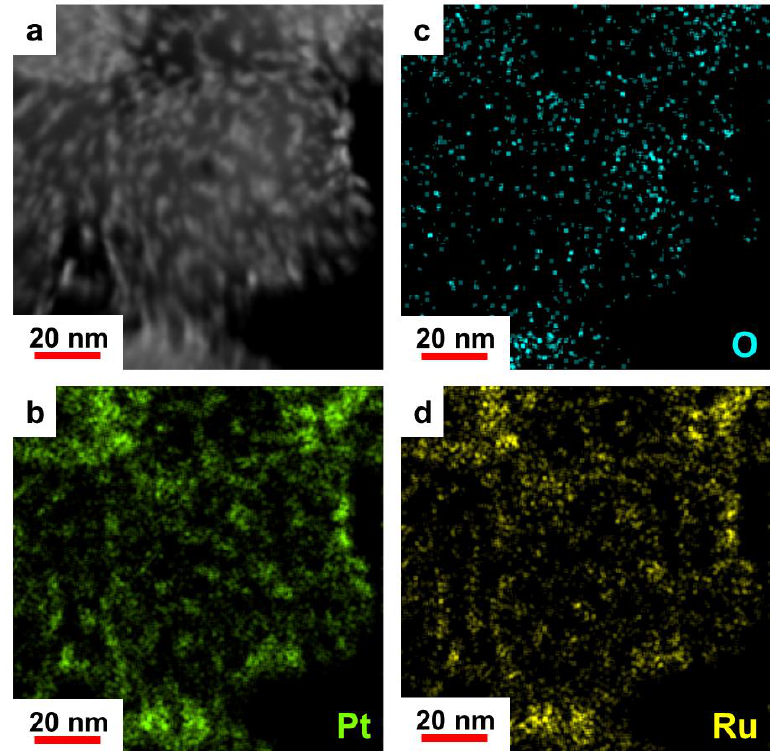
Figure 3. The elemental mapping of a surface section for the P sample: ( a ) the STEM micrograph of the surface; ( b ) the distribution maps of platinum, ( c ) oxygen, and ( d ) ruthenium. the surface; ( b ) the distribution maps of platinum, ( c ) oxygen, and ( d )